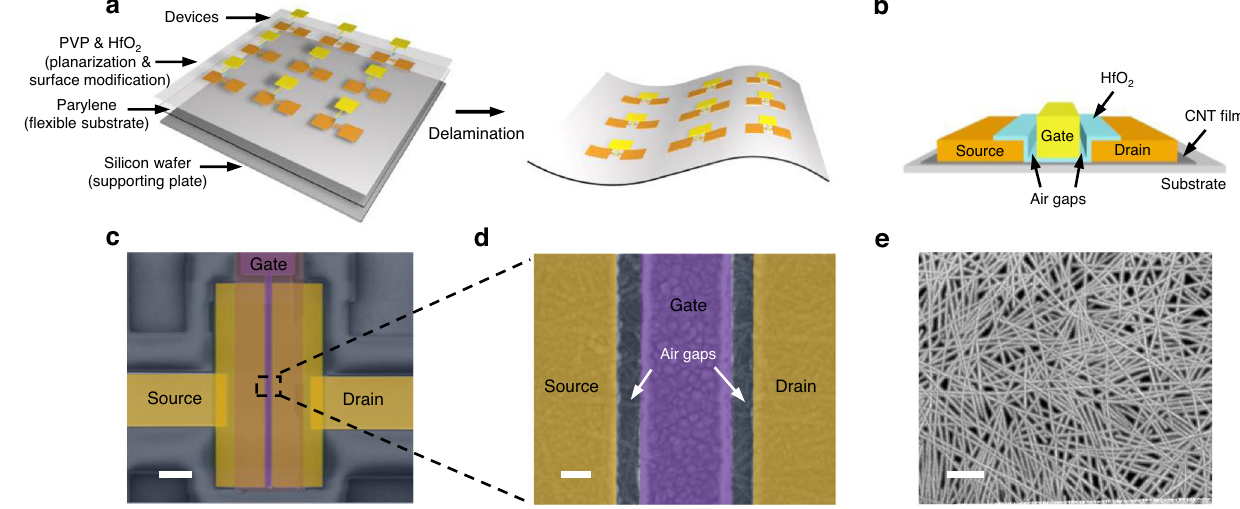
Fig. 1 | CNT-TFTs fabricated on a fl exible parylene substrate. a Schematic illus- tration of device and circuit fabrication on a fl exible parylene substrate. b Schematicdiagramofa fl exibleCNT-TFT. c